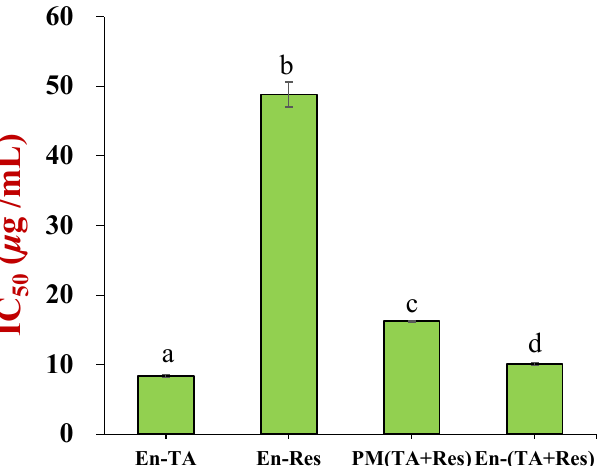
Figure 8. The HepG2 cell toxicity (IC 50 ) of encapsulated tannic acid, resveratrol, and co-encapsulated tannic acid and resveratrol (the letter “a–d” represents a statistically significant difference between two groups, p < 0.05).